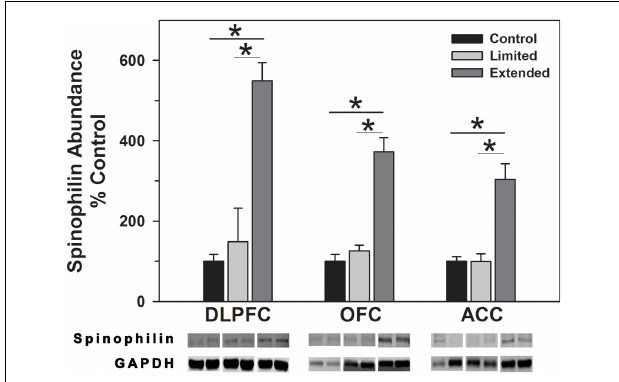
FIGURE 5 |Western blot analysis of spinophilin protein levels in prefrontal regions following limited and extended access to cocaine self-administration . Cytosolic fractions were isolated as described in the Section “Materials and Methods” and 10 µ g were separated on 10% SDS-PAGE. Data are expressed as mean ( ± SEM) of the percent of control values per amount of protein loaded. Asterisks indicate a significant difference ( P < 0.05). Bottom Panel: Representative bands from two subjects per group per region.